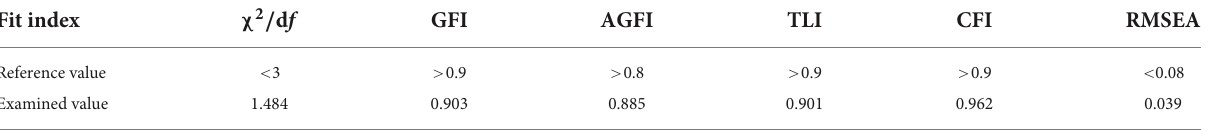
TABLE 3 Fit indices of measurement and structural